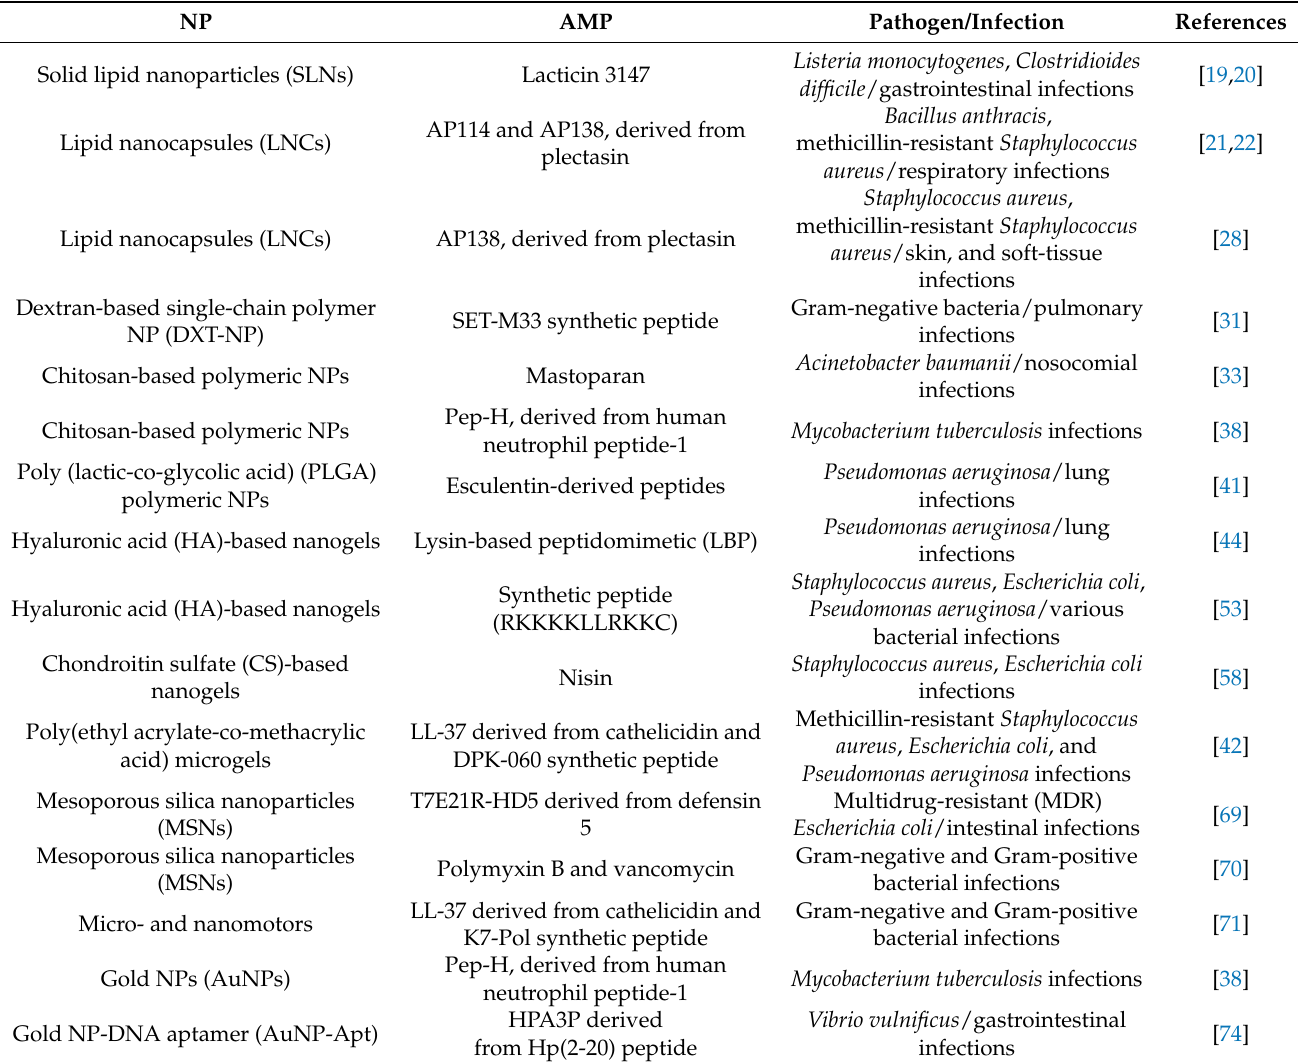
Table 1. The most representative studies reporting innovative NPs as delivery systems for AMPs against bacterial